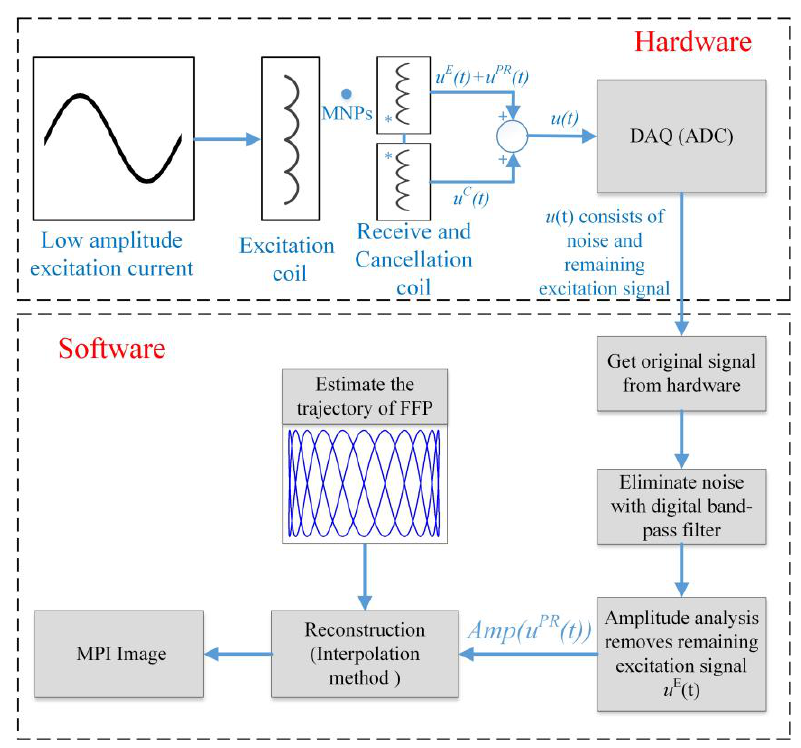
Figure 3. Signal flow diagram of the realized set-up.